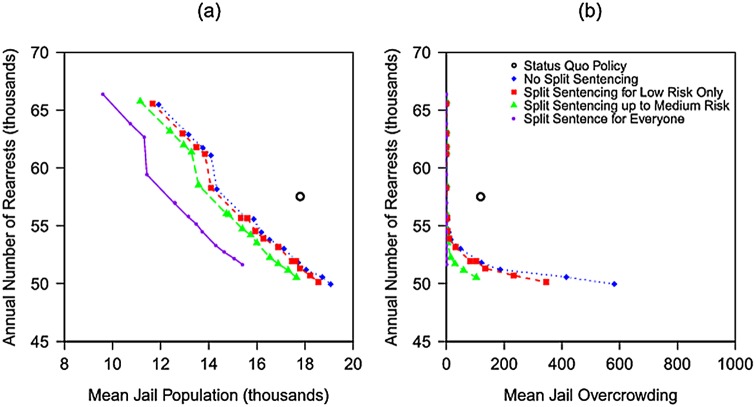
For each of the four options for split sentencing in the right column of Table 1, the optimal (i.e., optimizing over the remaining 16 options in Table 1) tradeoff curves of the annual rearrest rate vs.
(a) the mean jail population and (b) mean jail overcrowding. The circle denotes the status quo policy for LA County in early 2014.